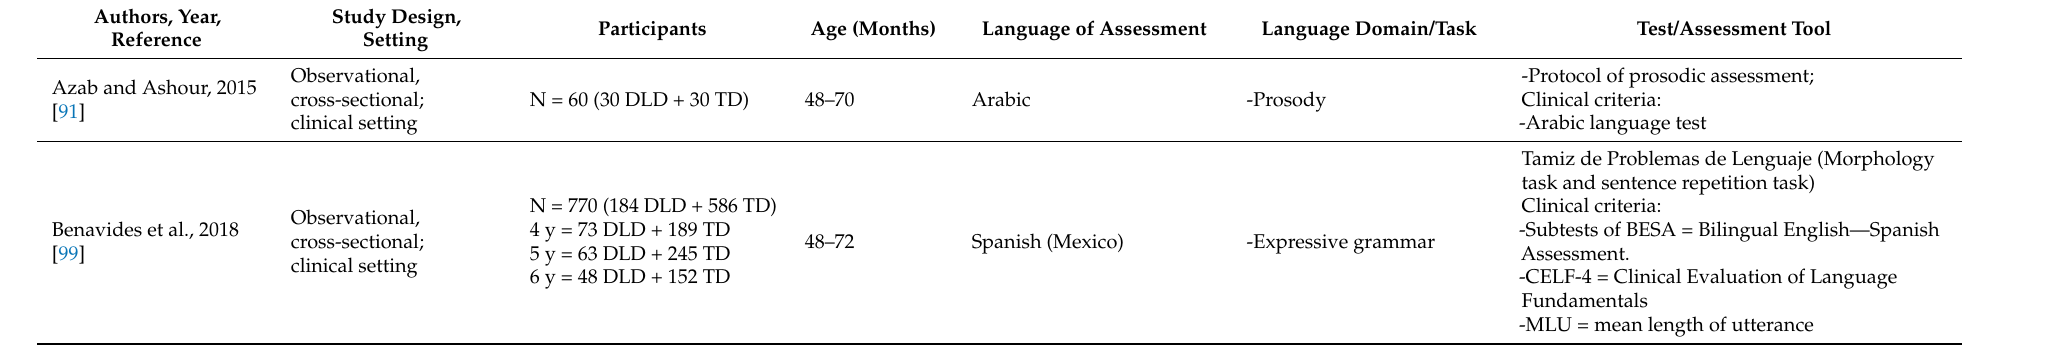
Table A3. Characteristics of the 27 selected primary